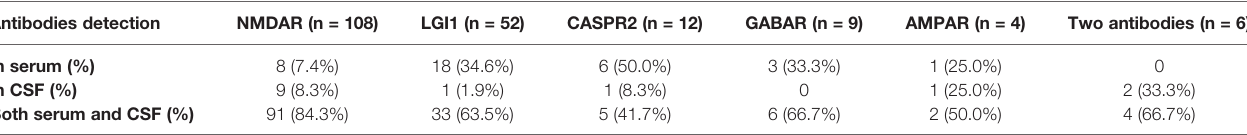
TABLE 3 | The data of antibodies detection in patients with